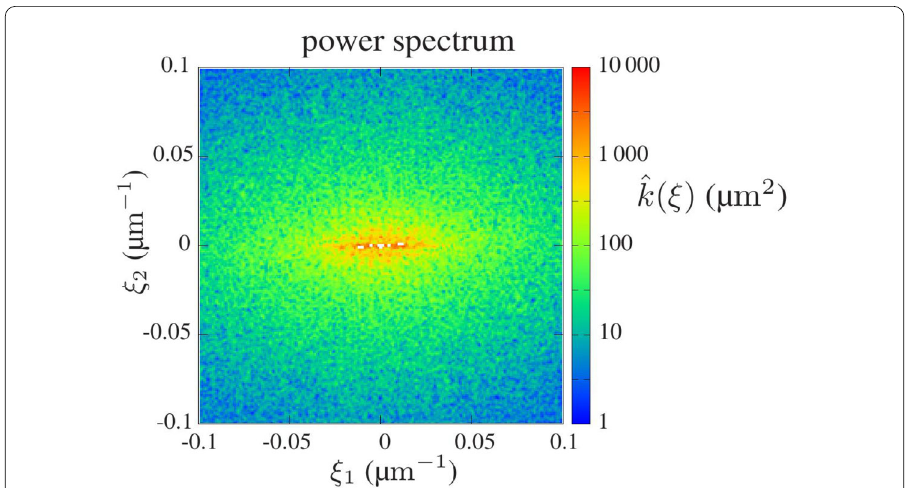
Figure 12 Estimate of the power spectrum ˆ k ( ξ ) of FL2 based on the image Fig. 11a